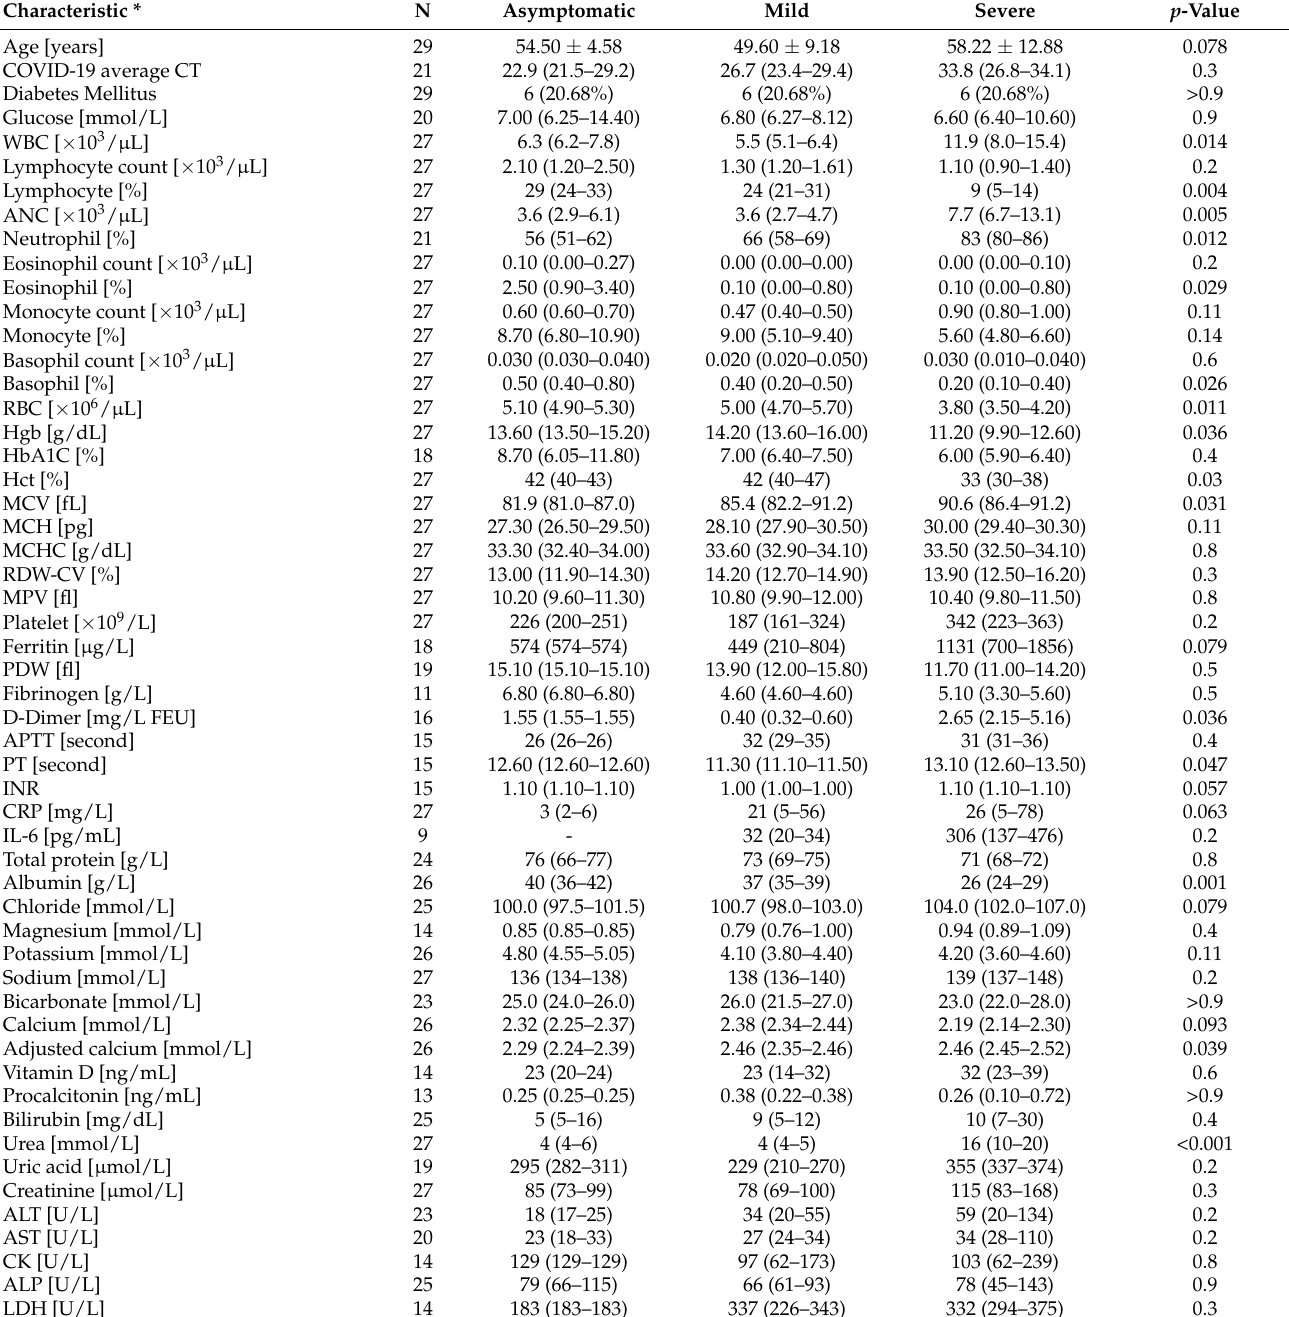
Table 1. Clinical characterization of asymptomatic, mild, and severe COVID-19 patients. Patients were grouped based on clinical disease severity including severe requiring oxygen support and ICU admission, mild cases were recognized as those with clinical symptoms and positive radiographic findings suggestive of pulmonary involvement. * ALP: Alkaline phosphatase, ALT: Alanine aminotransferase, ANC: Absolute neutrophil count, APTT: Partial thromboplastin time, AST: Aspartate aminotransferase, CK: Creatine kinase, CRP: C-reactive protein, Hct: Hematocrit, Hgb: Hemoglobin, IL-6: Interleukin-6, INR: International normalized ratio, LDH: Lactate dehydrogenase, MCH: Mean cell hemoglobin, MCHC: Mean corpuscular hemoglobin concentration, MCV: Mean corpuscular volume, MPV: Mean platelet volume, PDW: